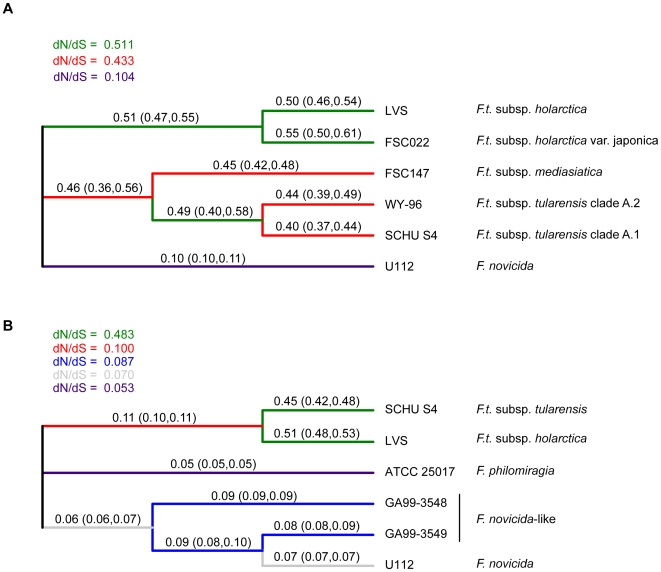
Likelihood estimates of dN/dS ratios across the Francisella phylogeny obtained using the software package Hyphy.The analysis indicates statistically significant differences in dN/dS values for different tree branches. Different colors represent the maximum number of rate classes estimated from the data using the Akaike information criterion (AIC) with a genetic algorithm. Values on the branches represent local optima, with confidence intervals in brackets. To optimize the evolutionary models comparisons were separately optimized for the phylogeny of (A) F. tularensis strains, and (B) the Francisella genus, including F. philomiragia and F. novicida.